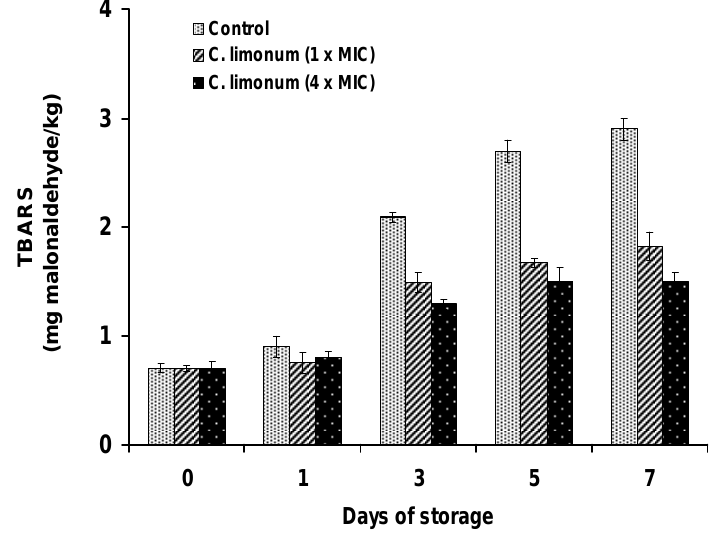
Figure 9. TBA-RS (mg malondialdehyde/kg) in Sardina pilchardus treated with lemon EO at different concentrations and stored at 8 ± 1 °C under aerobic conditions . Error bar represents the standard deviation for triplicate